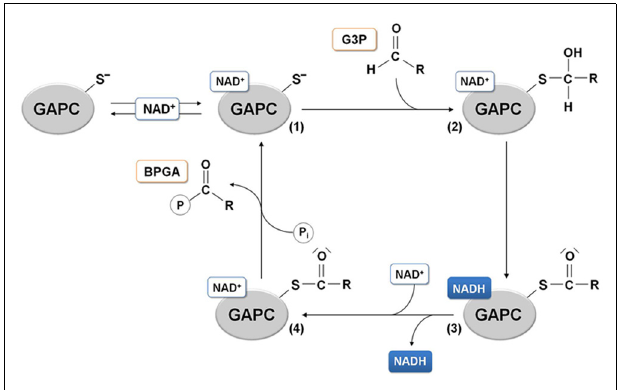
FIGURE 4 | GAPDH catalytic mechanism. In the glycolytic direction, the binding of the substrate glyceraldehyde-3-phosphate (G3P) to the holo-enzyme containing NAD + (1) leads to the formation of a hemithioacetal intermediate (2). In the next redox step, hydride transfer from the covalently bound substrate to the coenzyme allows formation of NADH, that can leave the acyl-enzyme (3) and be substituted by a molecule of NAD.The NAD-acyl-enzyme (4) can finally accept a free inorganic phosphate to release the product 1,3-bisphosphoglycerate (BPGA).